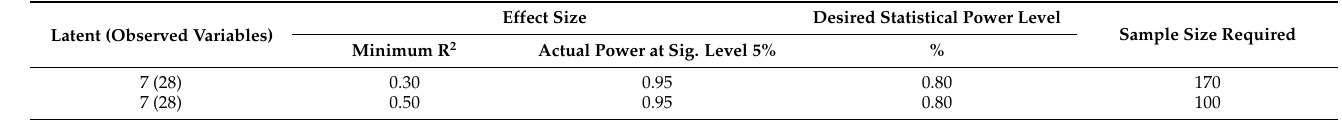
Table 3. Results of a priori statistical power analysis for the research